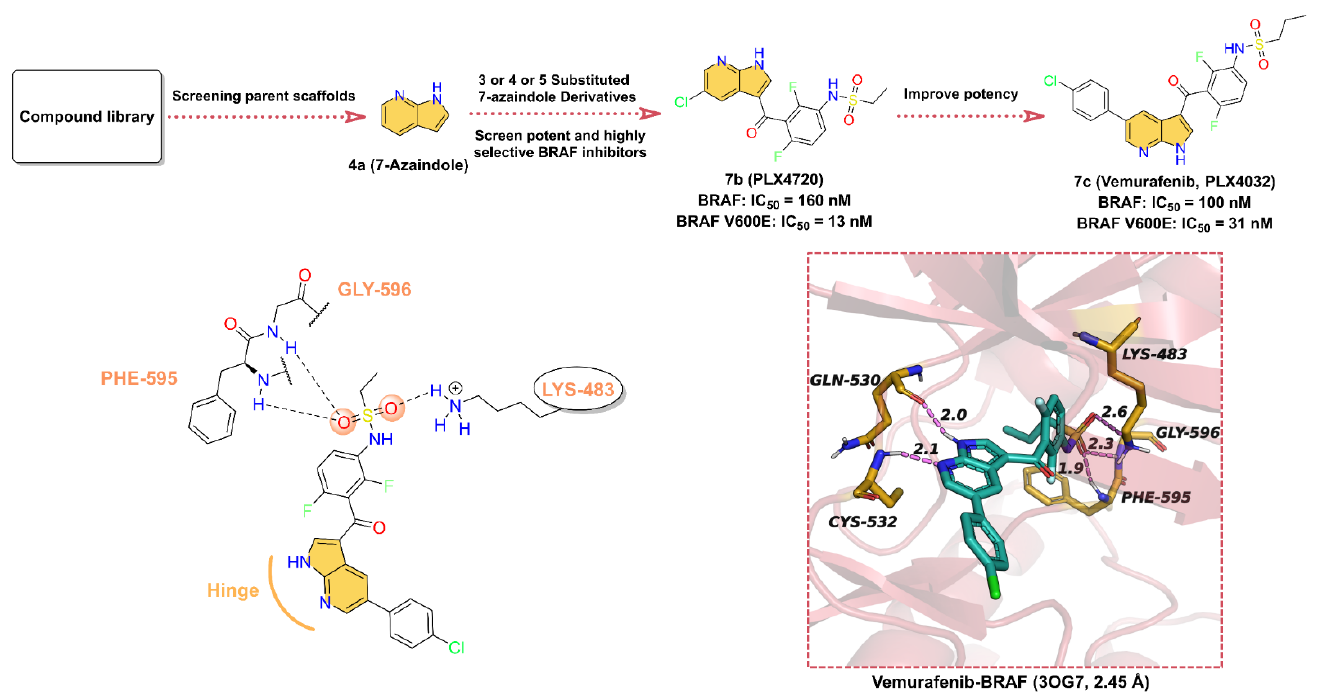
Figure 7. Key medicinal chemistry optimization of BRAF inhibitors along with the binding models with BRAF.